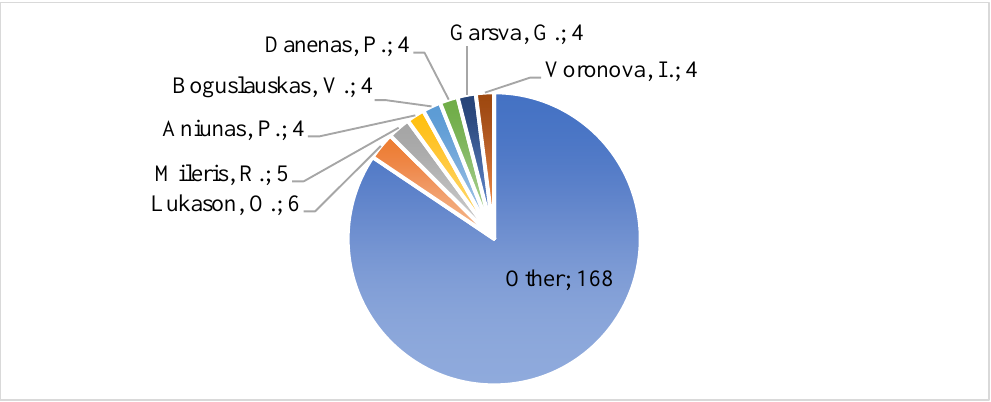
Fig. 5. Documents by the author’s (co-author’s) name.